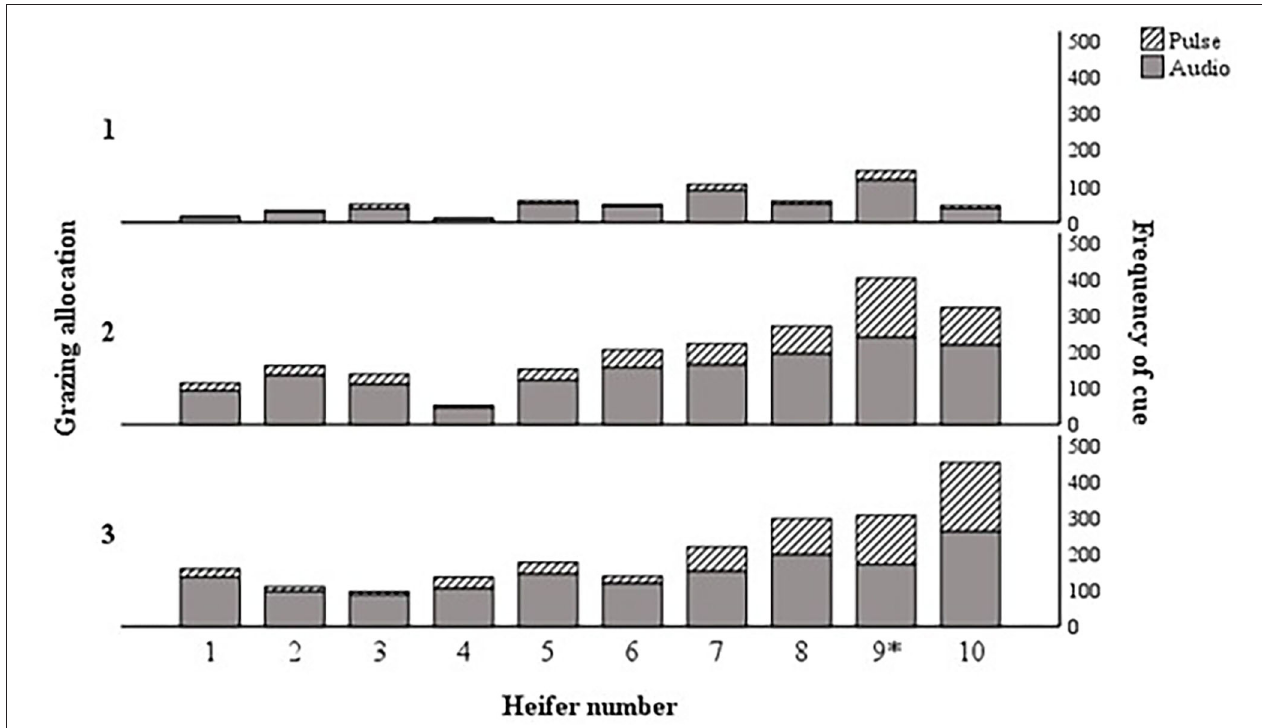
FIGURE 5 | Frequency of audio and electrical stimuli delivered to individual heifers from VF group 1 in grazing allocations 1, 2, and 3. *The neckband of heifer 9 did not record stimuli data at day 3 of allocation 3. Frequency of cues delivered to heifer 9 may thus be higher in allocation 3 than